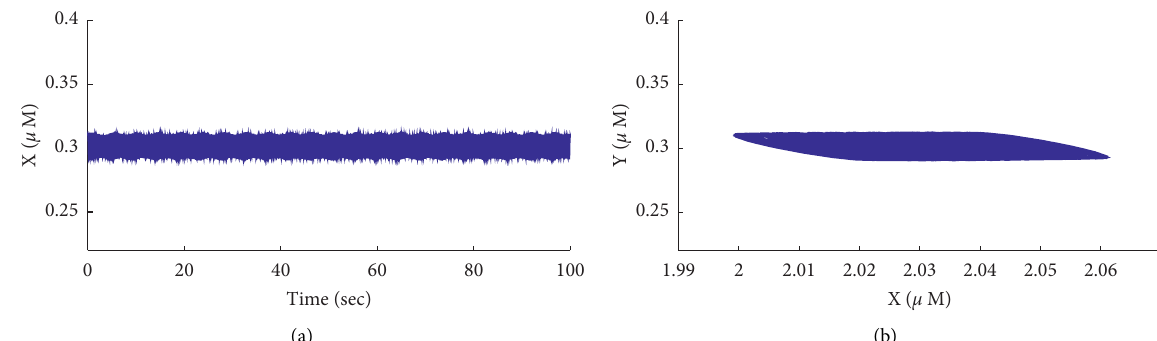
Figure 4: Large-amplitude feedback control of chaotic Ca 2+ oscillation in coupled model (6) of nonexcitable cell at r � 0.95. (a) The respective time course of variable X with controlling rate parameters k c1 � 0.1, k c2 � 0.1. (b) 2D projection of the trajectory in X, Y phase space with controlling rate parameters k c1 � 0.1, k c2 �